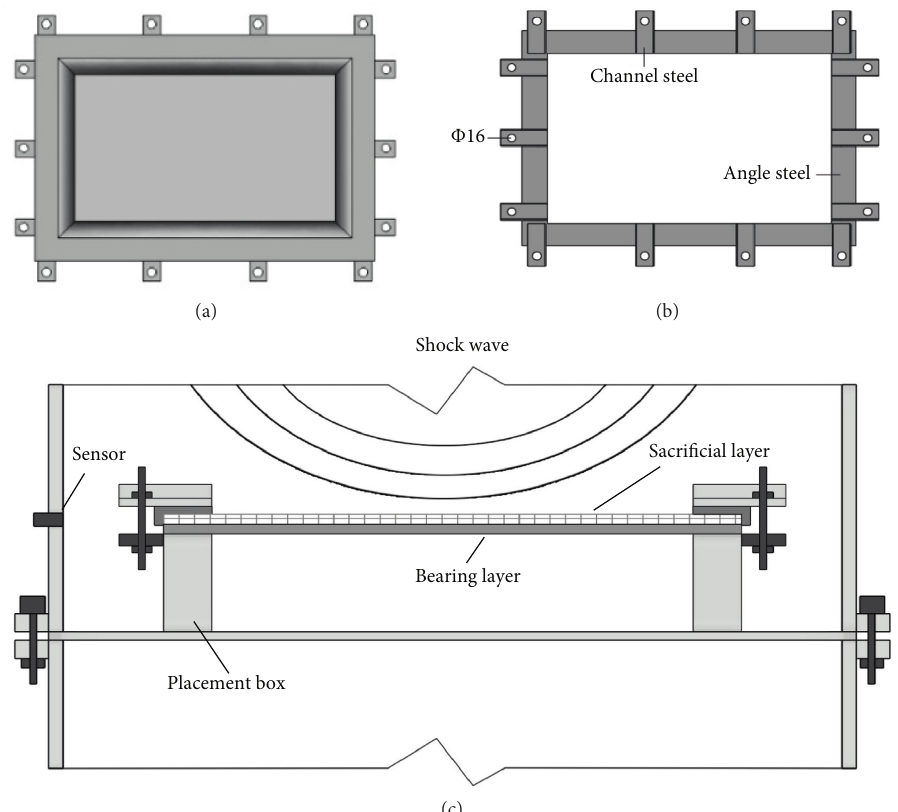
Figure 6: Schematic diagram of specimen assembly. (a) Schematic diagram of placement box. (b) Schematic diagram of stationary fixture. (c) Schematic diagram of assembly effect.